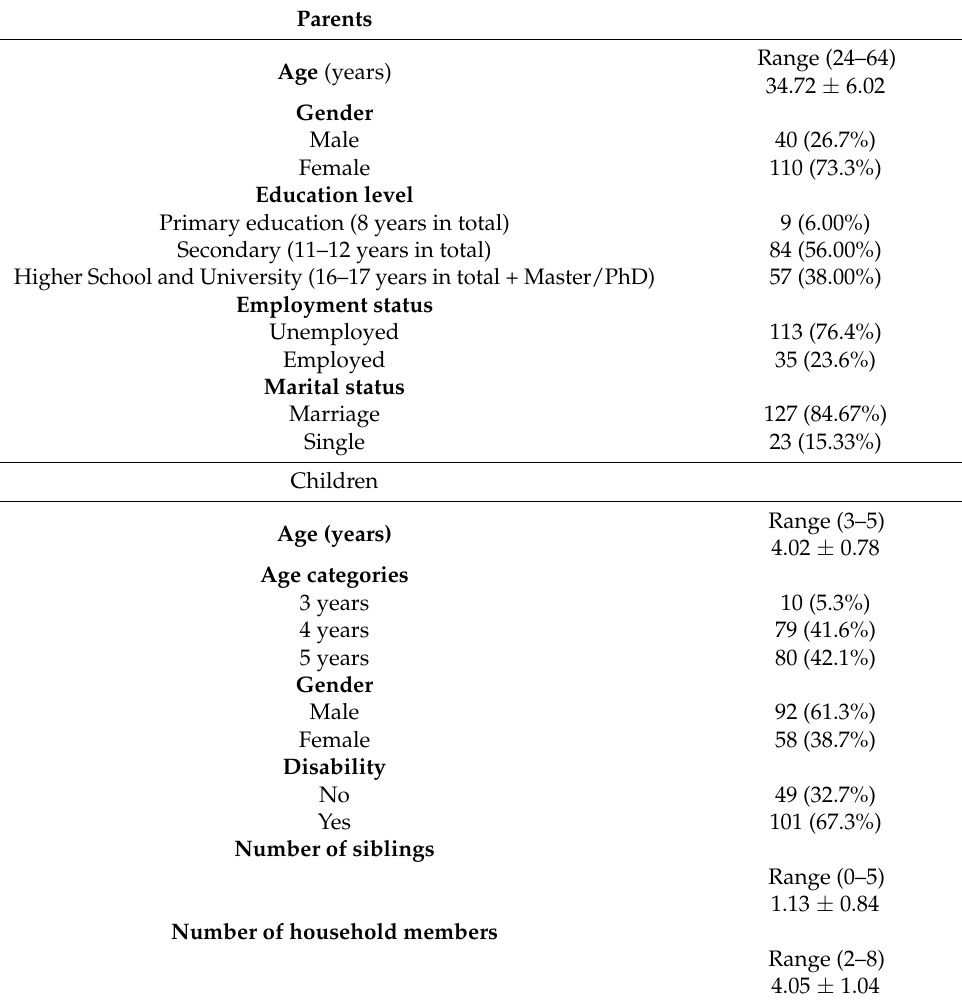
Table 1. Sociodemographic characteristics of the study